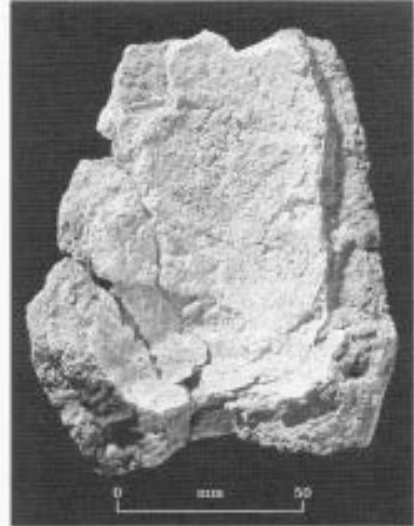
Figure 3 The bottom fragment of a reac­ tion vessel with remains of parting layer and semi-finished glass on the inside.